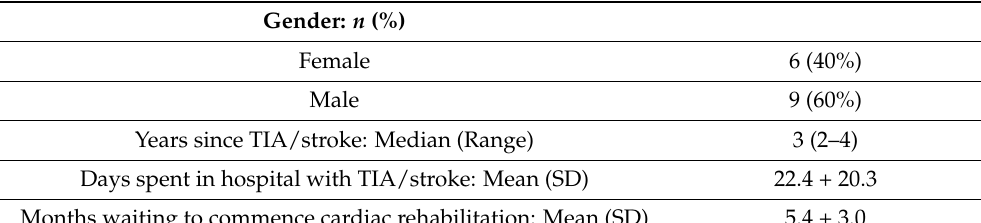
Table 2. Descriptive statistics of study participants who attended cardiac rehabilitation. Gender: n (%) Female 6 (40%) Male 9 (60%) Years since TIA/stroke: Median (Range) 3 (2–4) Days spent in hospital with TIA/stroke: Mean (SD) 22.4 + 20.3 Months waiting to commence cardiac rehabilitation: Mean (SD) 5.4 +